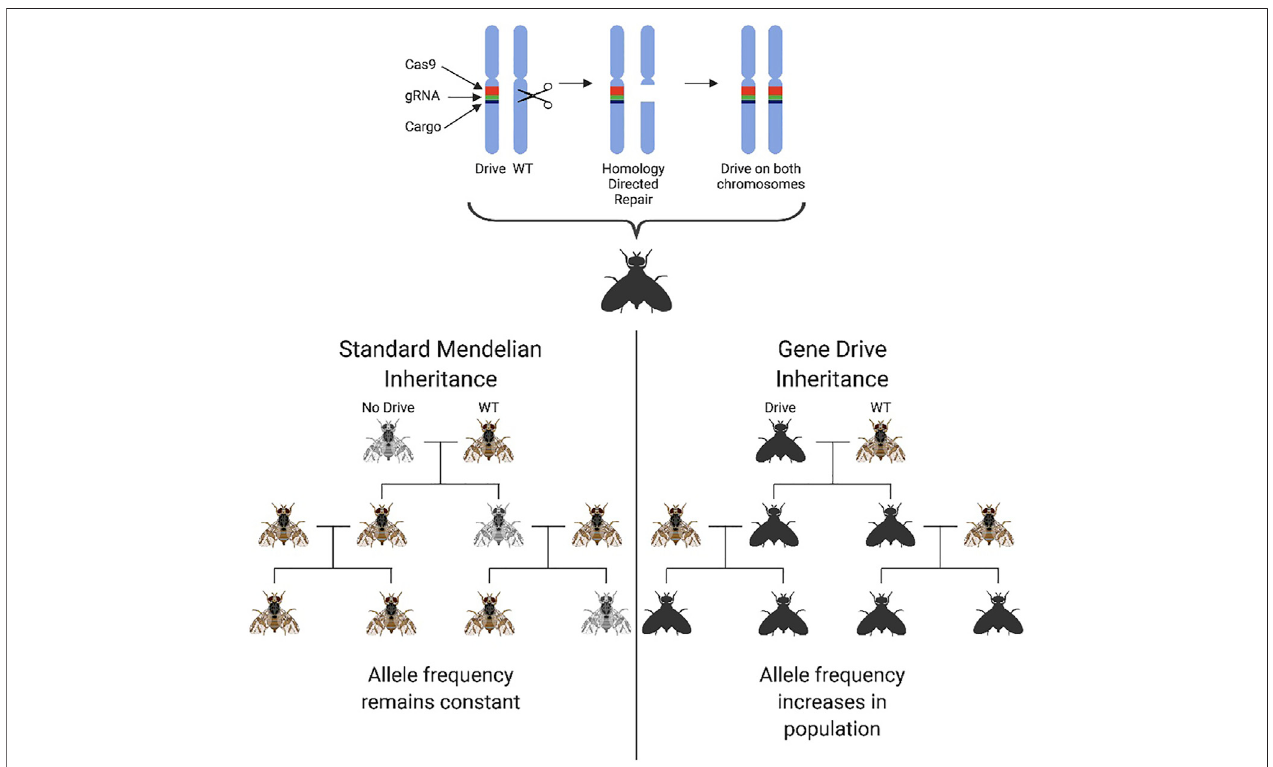
FIGURE 3 | The genetic principle and biased inheritance of a homing gene drive. Homing drives ensure their own transmission to the next generation through homology-directed repair. The Cas9 element of the construct, coupled with speci fi c guides, cut the wildtype chromosome at a precise genomic location triggering a double-strand break. This break is then repaired using homology-directed repair with the remaining chromosome being used as a template. The drive construct is therefore present on both chromosome copies ensuring 100% offspring inheritance. A cargo element is also coupled with the drive elements which can spread a desired trait through a population. This biases the usual 50% inheritance mandated by standard Mendelian genetics and results in the 100% inheritance of the drive in offspring.Thedrivefrequencyinthepopulation willthereforeincreasewithsubsequentpopulationsasopposedtothestandardmendelianinheritanceat whichtheallele frequency would remain at a constant level in the population if a fi tness cost is not